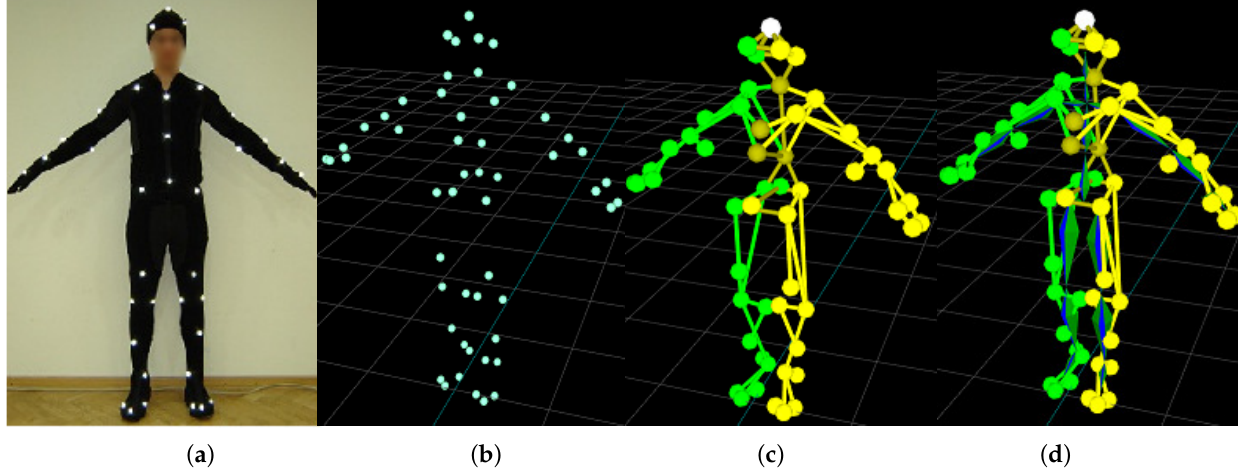
Figure 1. Stages of the motion capture pipeline: actor ( a ); registered markers ( b ); body mesh ( c ); mesh matched skeleton ( d